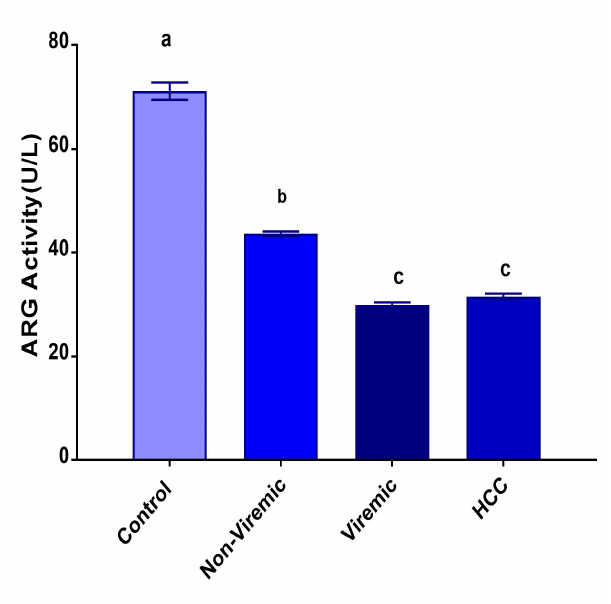
Figure 2. Comparison ARG activities in all studied groups . Each value repre- sents the mean ±